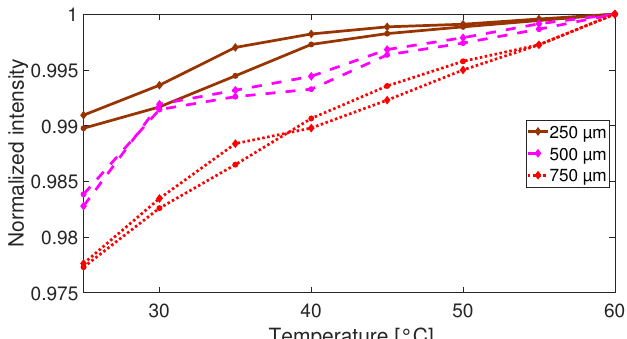
Figure 11. Thermal response of the SWWs for different gap sizes of 250 µm (brown line), 500 µm (dashed magenta line), and 750 µm (dotted red line). The measurements were performed with the diode laser at λ = 850 nm. The two lines for each color corresponds to the heating and cooling cycle,